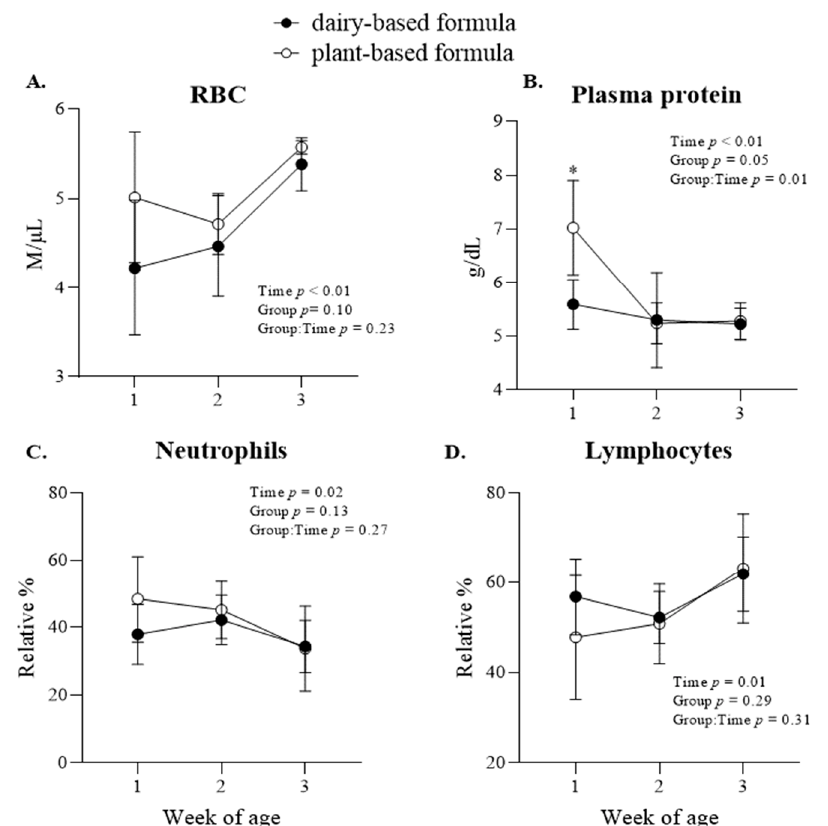
Figure 7. Plasma cell count variables: red blood cell—RBC ( A ), plasma protein ( B ), relative (%) neutrophils ( C ) and lymphocytes ( D ) at 1, 2, and 3 weeks of age of piglets fed either a dairy-based (Similac Advance powder) or a plant-based (Else nutrition powder) formula ( n = 9/group) from postnatal day (PND) 2 until PND 21. * Represents the statistical difference between diet groups at the given time point. Table 6. Cell plasma count variables (group average) by week of age (w1, w2, w3) of piglets fed either a dairy-based or a plant-based formula ( n = 9/group) from postnatal day (PND) 2 until PND 21. p 4 p -Adjusted 5 Dairy-Based Formula 1 Plant-Based Formula 2 SEM 3 Time Group Group × Time w1 w2 w3